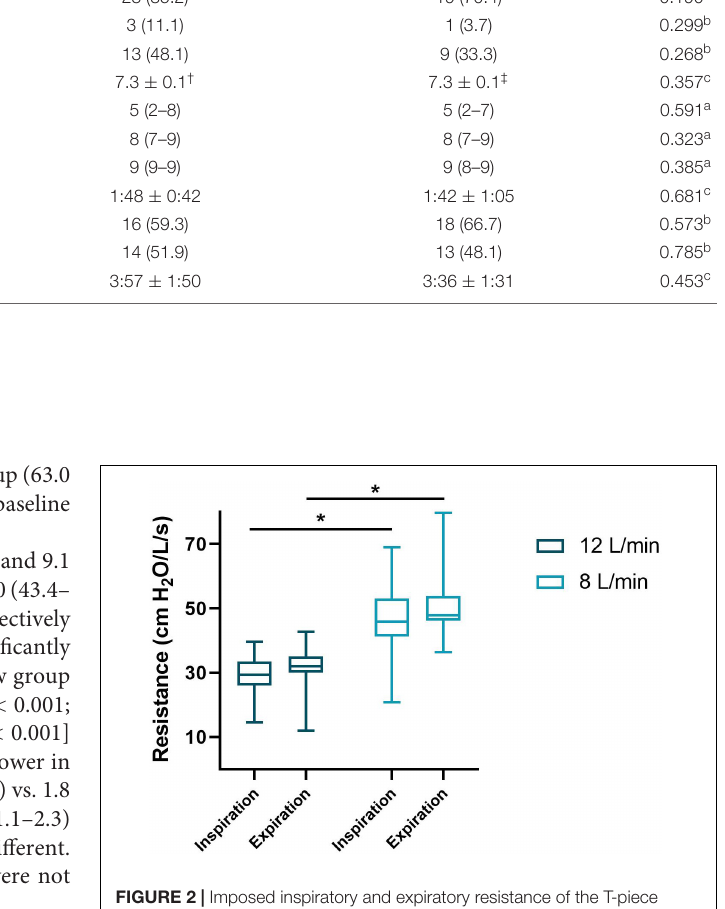
FIGURE 2 | Imposed inspiratory and expiratory resistance of the T-piece during spontaneous breathing on CPAP. The median (IQR) resistance (y-axis) for inspiration and expiration of both groups (x-axis) are presented in this boxplot. ∗ p <